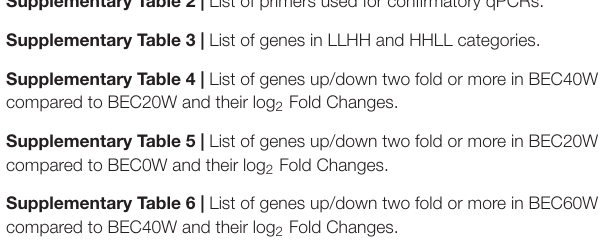
Supplementary Table 2 | List of primers used for confirmatory qPCRs. Supplementary Table 3 | List of genes in LLHH and HHLL